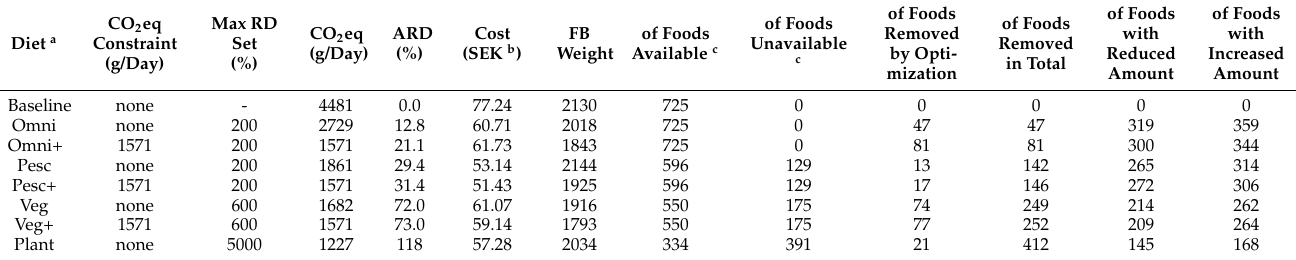
Table 2. Cost, average relative deviation (ARD), min/max relative deviation (RD) values, CO 2 eq values, and the number of foods removed, reduced or increased in the optimized diets for omnivores, pescatarians, vegetarians, and vegans compared with the baseline consumption of Swedish